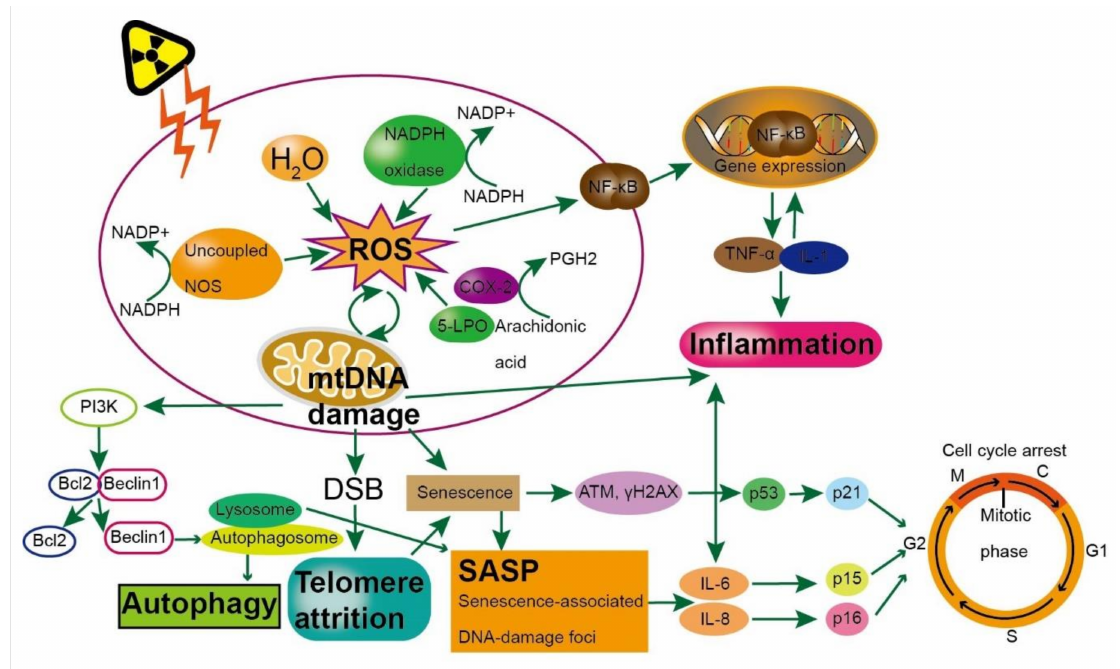
Figure 2. Interactions between various mechanisms of brain aging induced by ionizing